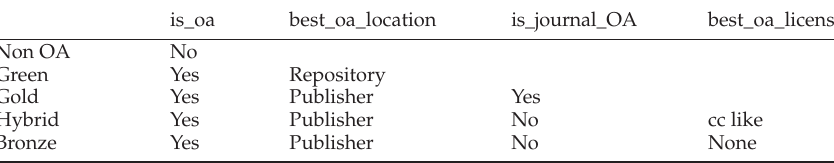
Table 1: Classification of open access levels according to the values of four fields provided by Unpaywall